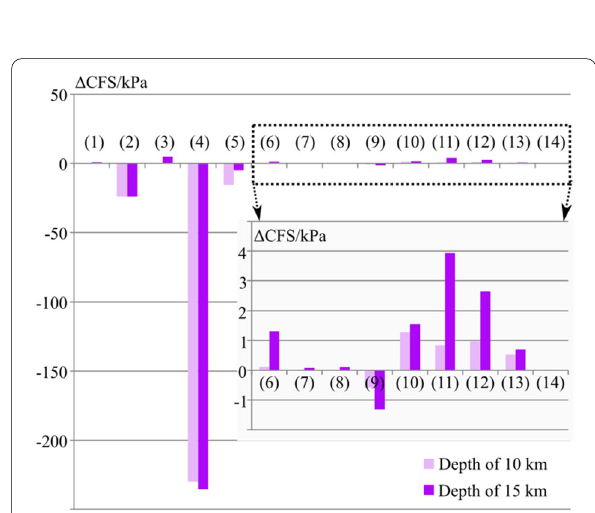
Fig. 5 The coseismic and postseismic ΔCFS at the epicenter of 2021 Maduo earthquake induced by historical earthquakes, at different depth 10 km and 15 km